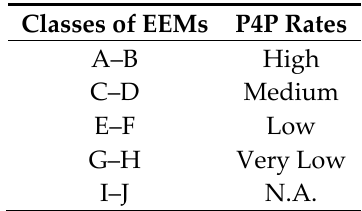
Table 2. P4P rates as a function of class of